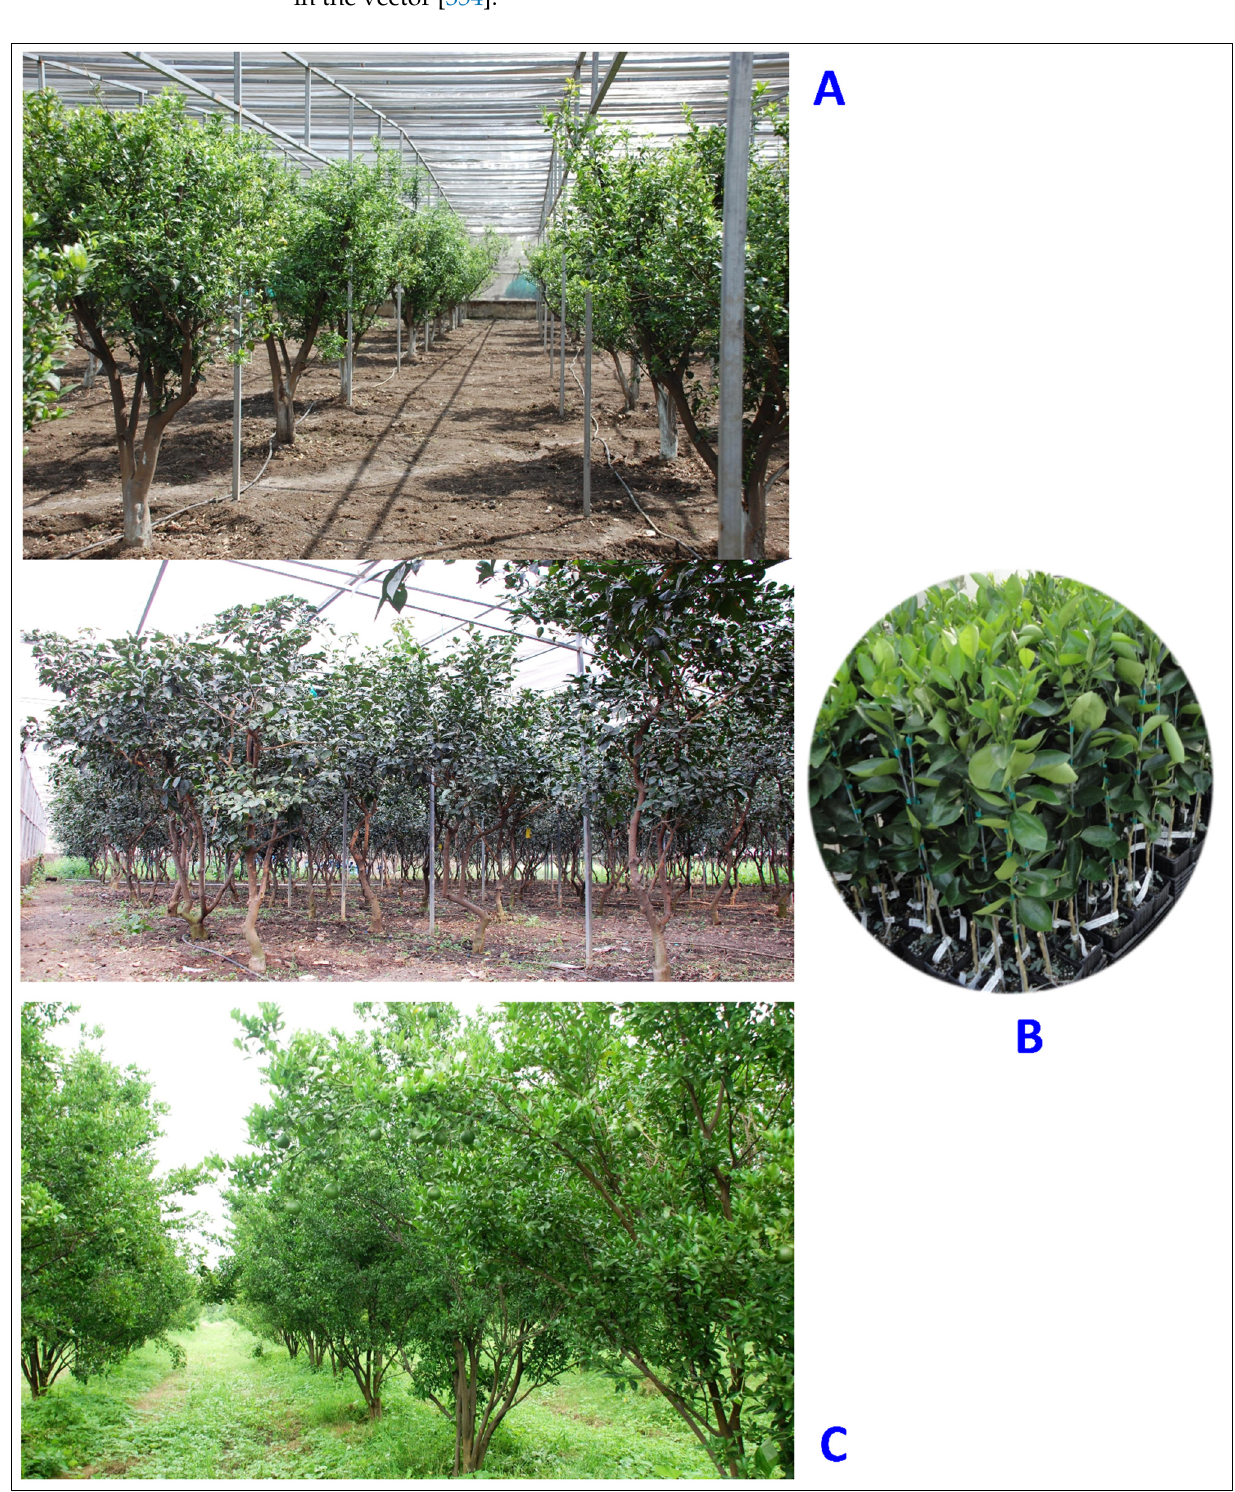
Figure 13. ( A ). Protected mother plants of Nagpur mandarin (Source of HLB and Virus-free scion) ( B ). Certified HLB-free-quality nursery citrus plants ( C ). Well-established healthy orchard of Nagpur mandarin.